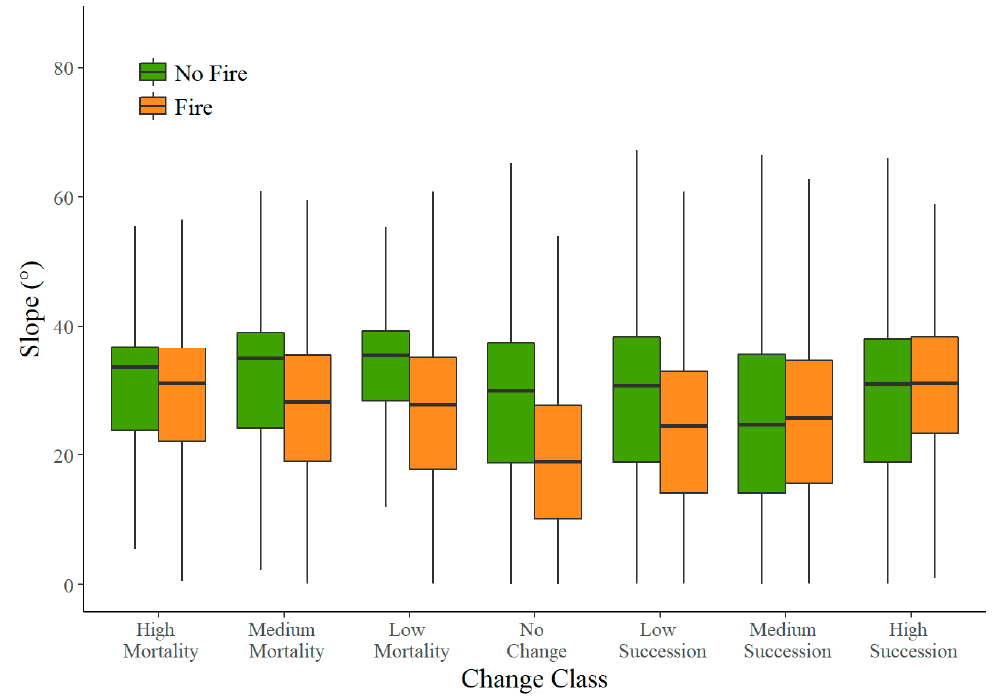
Figure 11. Distribution of slope within change class, factored by fire exposure. Median slope was generally higher in regions that were not exposed to fire.